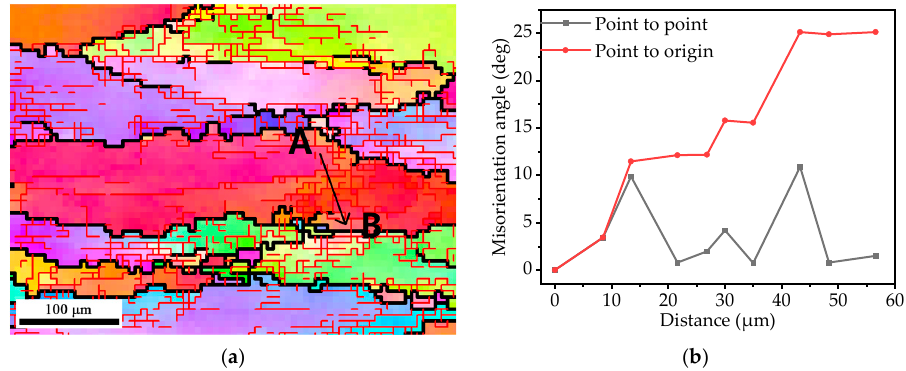
Figure 13. cDRX of Ti − 65541 alloy in region D: ( a ) EBSD map, ( b ) the map of misorientation.